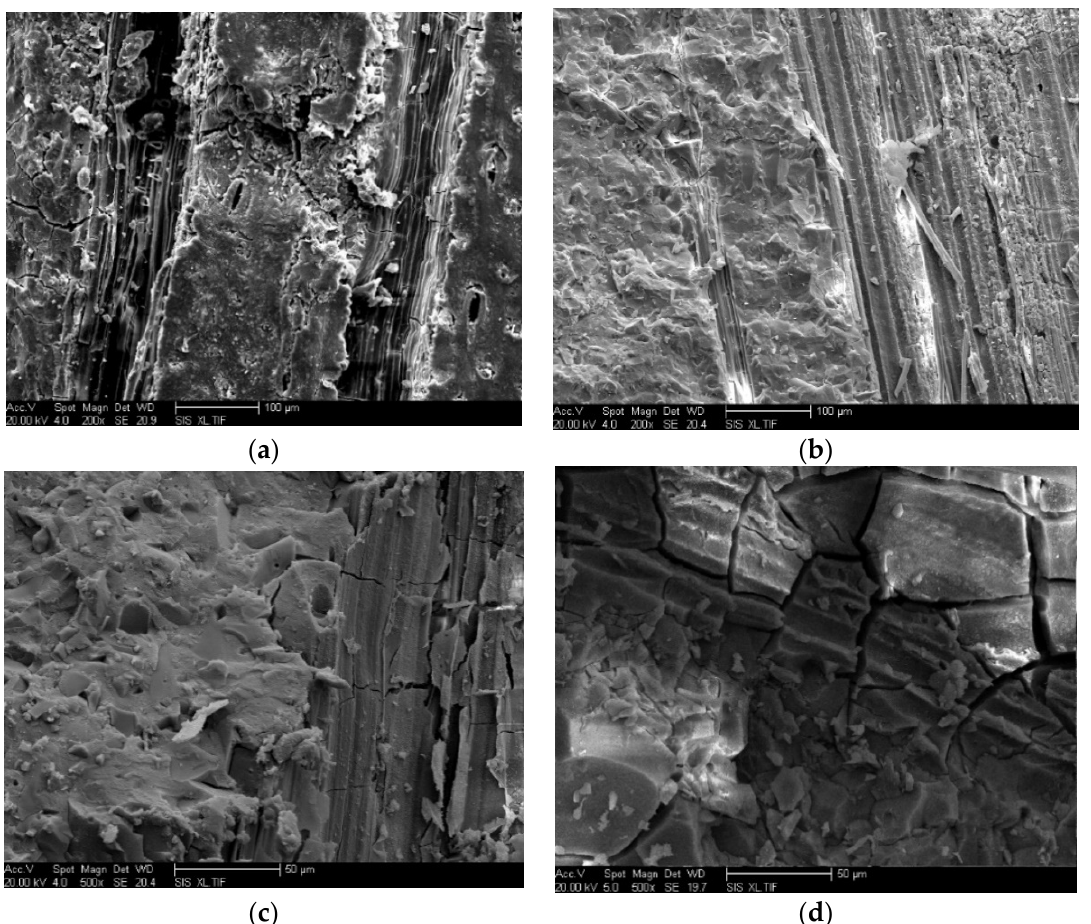
Figure 11. The SEM morphology of alkali-activated blast furnace slag powder measured at high temperature environment. ( a ) 200 °C. ( b ) 400 °C. ( c ) 600 °C. ( d ) 800 °C.